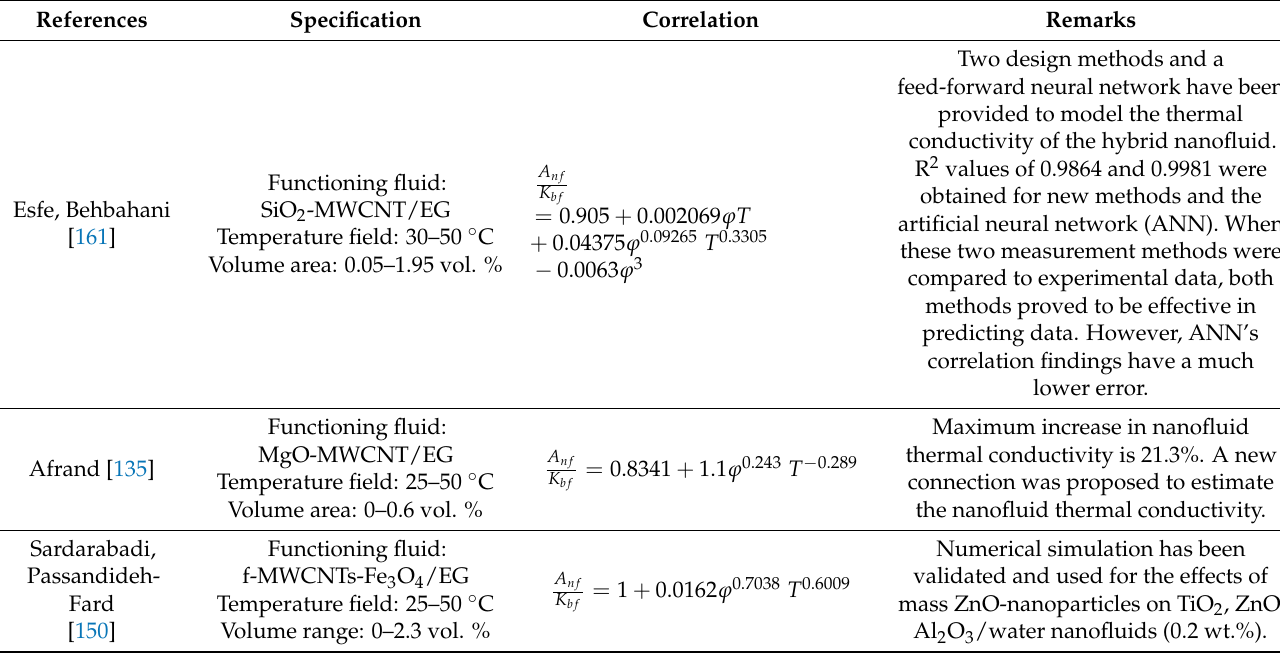
Table 4. Mathematical expression of solar